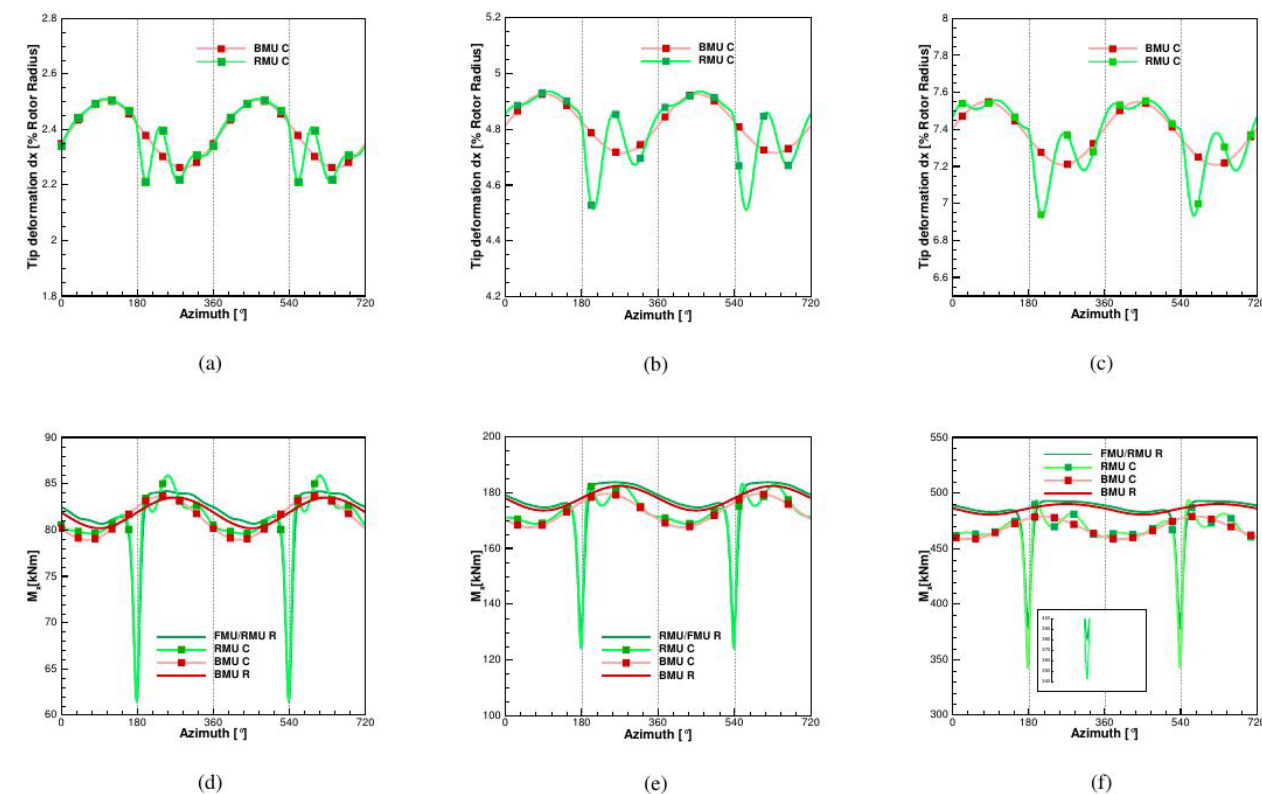
Figure 8. Aeroelastic calculations using BEM as aerodynamic model. Tip deformations in flapwise direction BMU vs. RMU: 6.1ms − 1 in (a) , 9.0ms − 1 in (b) and 13ms − 1 in (c) . Torque ( M x ) generated by one-blade BMU vs. RMU: 6.1ms − 1 in (d) , 9.0ms − 1 in (e) and 13ms − 1 in (f) .